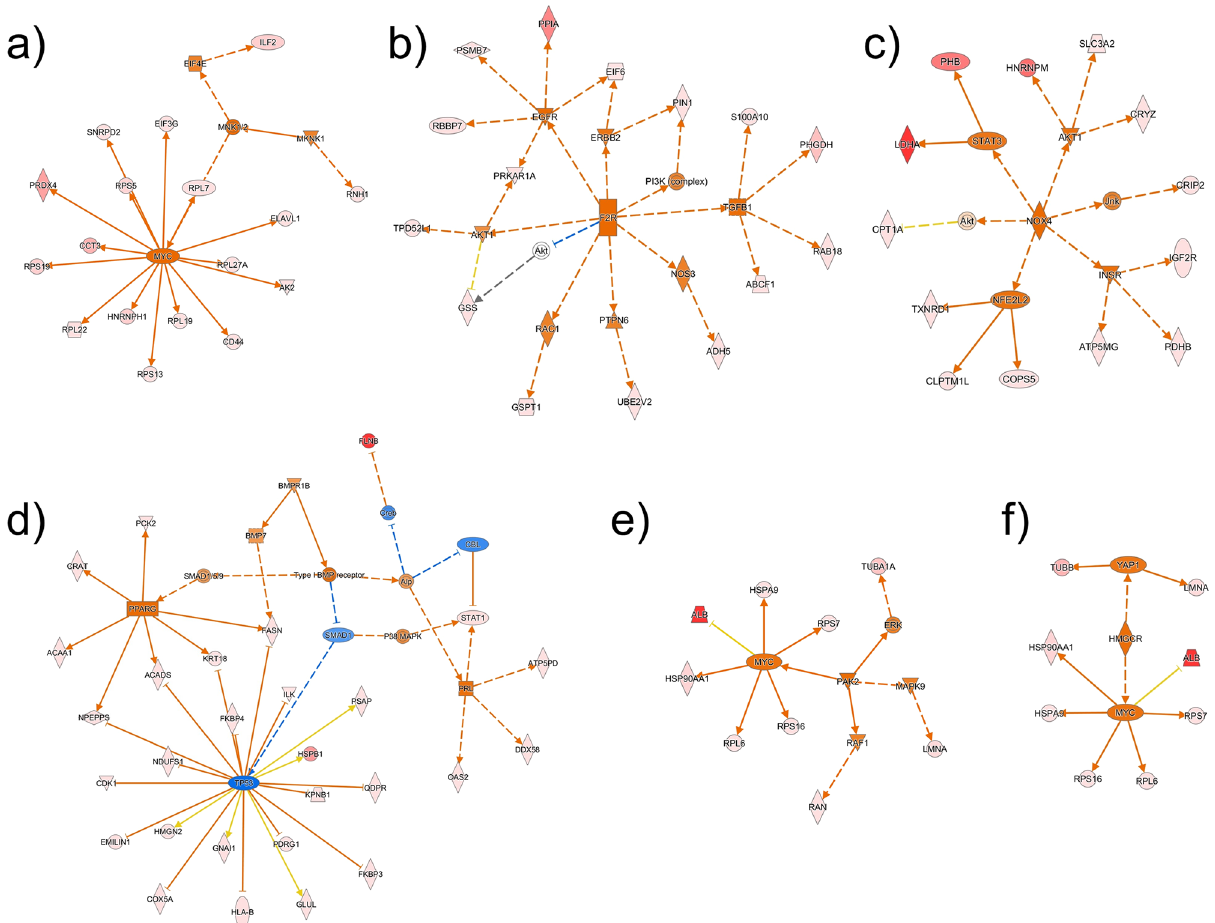
Figure 5. Causal network modules of ( a ) MNK1/2, ( b ) F2R/PAR1, ( c ) NOX4, ( d ) BMP1 receptor, ( e ) PAK2, and ( f ) HMGCR, together with their target molecules in the dataset, which were representatively associated with the HOT trait. Node shapes indicate molecular types: triangle, kinase; square (dashed), growth factor; rectangle (horizontal), ligand-dependent nuclear receptor; rectangle (vertical), ion channel; diamond (vertical), enzyme; diamond (horizontal), peptidase; trapezoid, transporter; oval (horizontal), transcription regulator; oval (vertical), transmembrane receptor; double circle, complex; and circle, other. Red or light red colors indicate highly or moderately increased expression of a mutant protein in the dataset. Orange/light orange and blue/ light blue colors indicate the extent of confidence for predicted activation and inhibition, respectively. Lines denote predicted relationships. A solid or dashed line indicates direct or indirect interaction, respectively. Orange, leading to activation; blue, leading to inhibition; yellow, findings inconsistent with the state of a downstream molecule; grey, not predicted effect. BMP1, bone morphogenetic protein 1; F2R/PAR1, coagulation factor II thrombin receptor/ proteinase-activated receptor 1; MNK1/2, MAPK-interacting serine/threonine- protein kinases 1 and 2; NOX4, NADPH oxidase 4; PAK2, p21-activated kinase 2; HMGCR, 3-hydroxy-3- methylglutaryl-CoA